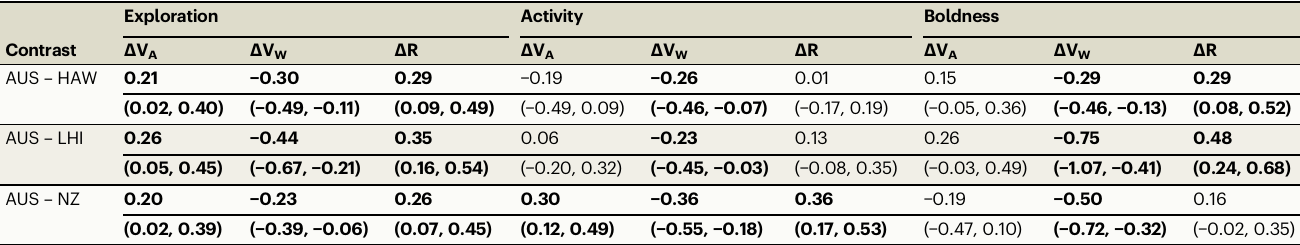
Table 1 | The effect size (±95% CI) of the magnitude difference in among-individual variation ( Δ V A ), within-individual variation ( Δ V W ), and repeatability ( Δ R) of exploration, activity, and boldness of lizards from Australia (AUS; n = 167 skinks), Hawaii (HAW; n = 118), Lord Howe Island (LHI; n = 92), and New Zealand (NZ; n = 143) Exploration Activity